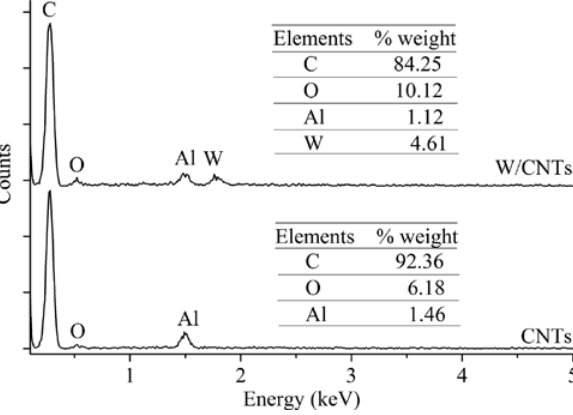
Figure 4: EDX analyses of CNTs and W/CNT.